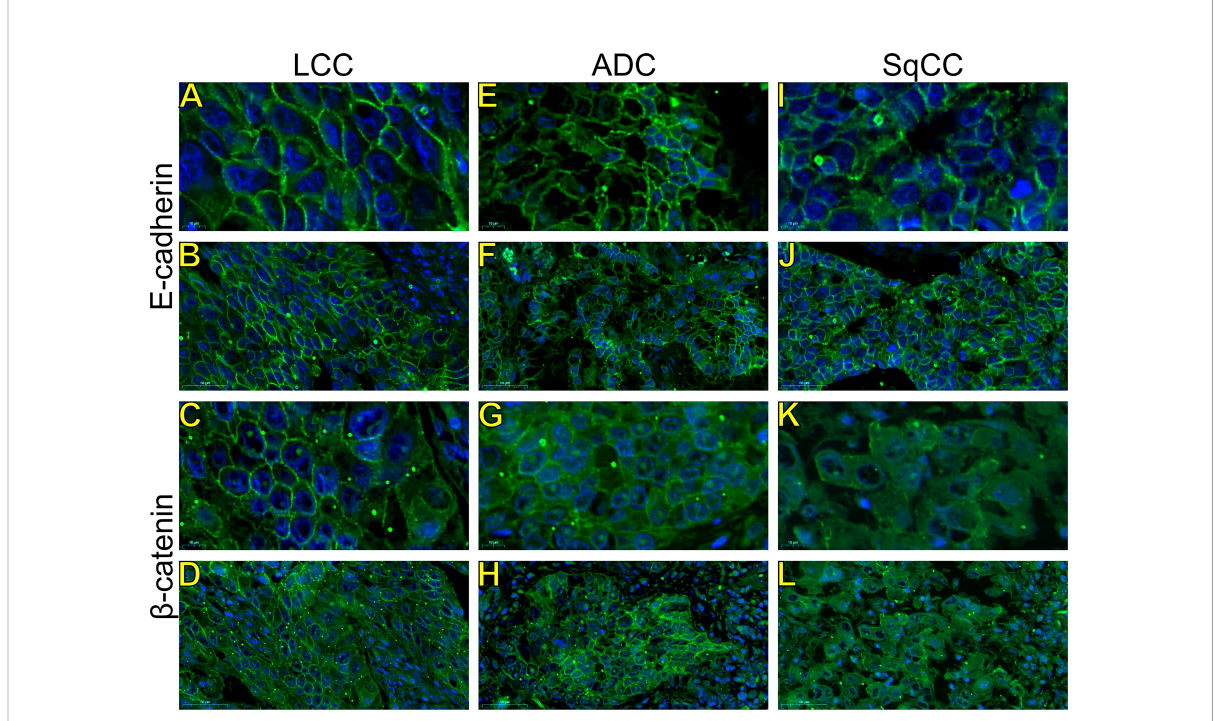
FIGURE 3 Expression of epithelial-to-mesenchymal transition-related markers. Images visualized under immuno fl uorescence microscope showing tumors and invasive groups of large cell carcinoma ( A, B , E-cadherin; C, D , b -catenin; respectively), adenocarcinoma ( E, F , E-cadherin; G, H , b -catenin; respectively) and squamous cell carcinoma ( I, J , E-cadherin; K, L , b -catenin; respectively) (N=120). Original magni fi cation: 100X and 40X. LCC, large cell carcinoma; ADC, lung adenocarcinoma; SqCC: lung squamous cell